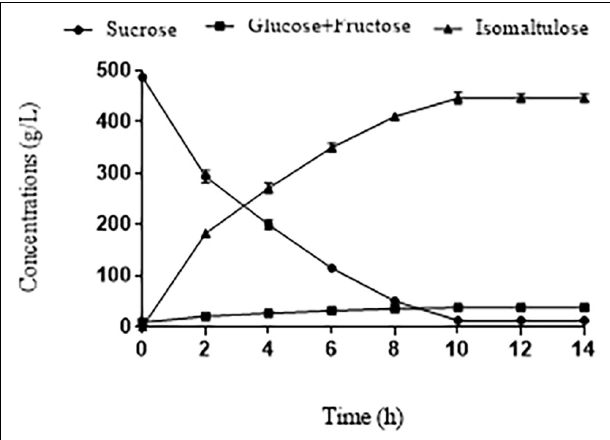
FIGURE 4 | Time course of sucrose conversion in pretreated BM under the best conditions (800 g/L pretreated BM, 40 ◦ C, 15 U/g of SIase, pH 5.5) by immobilized SIase in the eighth cycle.